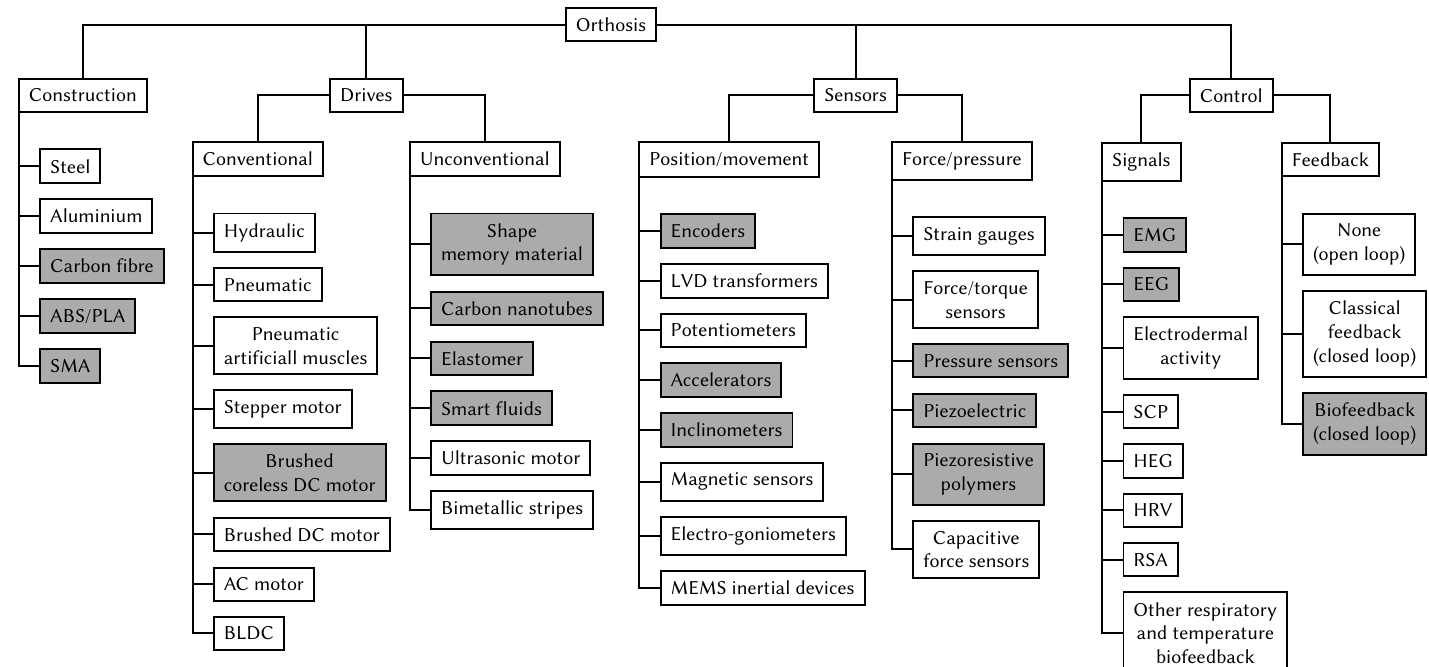
Figure 7. Summary of the main bionic orthosis elements described in the paper. Grey blocks indicate elements that are essential for future development of